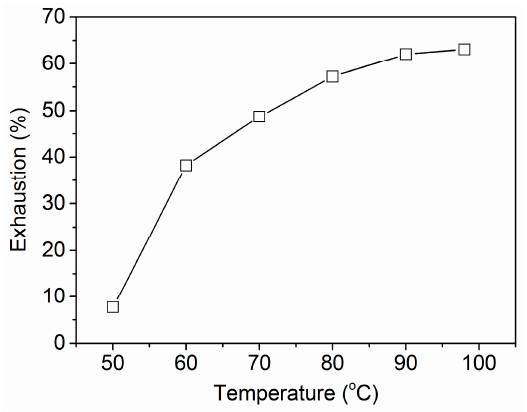
Figure 2. Effect of temperature on the uptake of PA by wool.